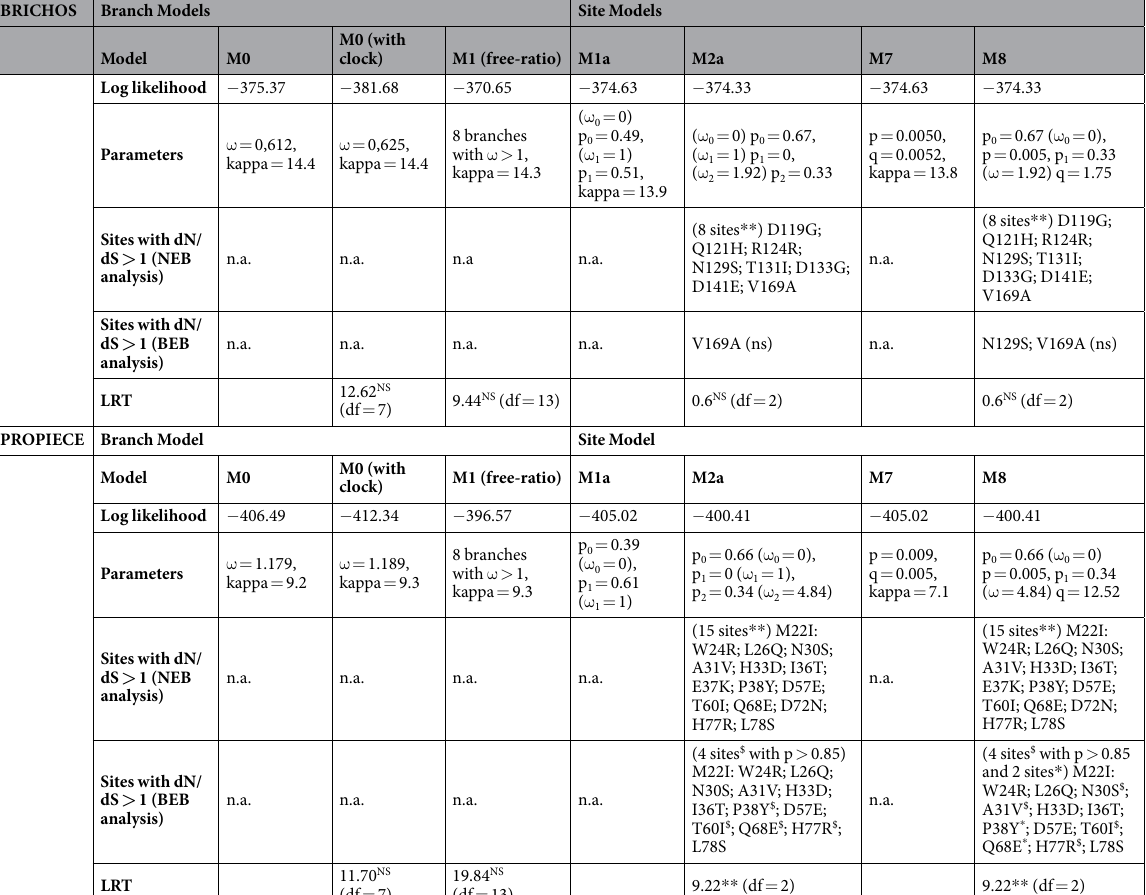
Table 2. Log-likelihood values and parameter estimates for the BRICHOS and propiece domains of the preproalvinellacin gene using models implemented in the CodeML program of the PAML package with the alignments of consensus paralogous sequences (8) and the reference tree selected by jModelTest 2.1.7 (BRICHOS: K80 + I, Propiece: Tim2ef I + G). M0 (one-ratio); M1 (free-ratio); M1a (nearly-neutral); M2a (selection); M7 ( β ); M8 ( β+ω > 1) and the estimated log-likelihood values (l) by the CodeML program, ω = dN/ dS nonsynonymous/synonymous rate ratio; p = proportion of sites for each site class. M0: one ω for the tree; M1: one ω per branch, M1a: p 0 = proportion of sites with ω 0 = 0, p 1 = 1 − p 0 , proportion of sites with ω 1 = 1; M2a: p 0 ( ω 0 = 0), p 1 ( ω 0 = 1), and ω 2 , p 2 = 1 − p 0 − p 1 . M7: p and q (parameters of β distribution of ω between 0 and 1). M8: same as M7 except the addition of one site class in which ω is greater than one. Positively Selected Sites: Codon positions predicted to be under positive selection with a posterior probability of acceptance of $ > 85%, * > 95% and ** > 0.99 (identification of sites exhibiting dN/dS ratio > 1) with either Naive Empirical Bayes (NEB) or Bayesian Empirical Bayes (BEB). Numbers refer to amino-acid positions from the initial methionine. LRT: likelihood ratio tests between substitution models (between nested branch models: M0 vs. M0 with clock, M0 with clock vs. M1; between nested site models: M1a vs. M2a, M7 vs. M8). NS: not significant, ** p <